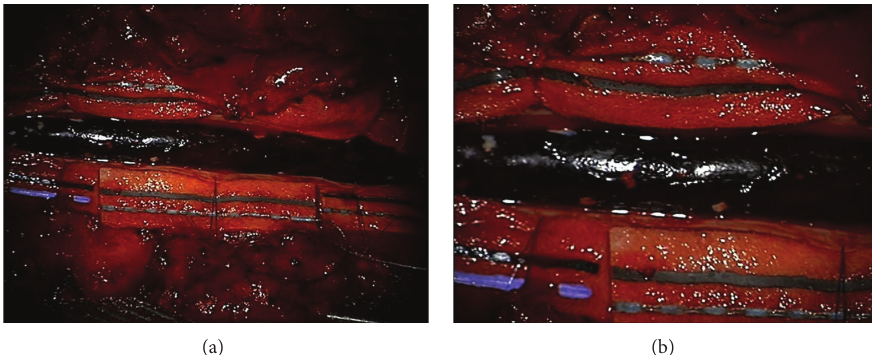
Figure 2: Intraoperative photographs taken using the operating microscope displaying (a) a large blood clot under the subarachnoid layer overlying the spinal cord and (b) arachnoid granulations on the surface of the hematoma.